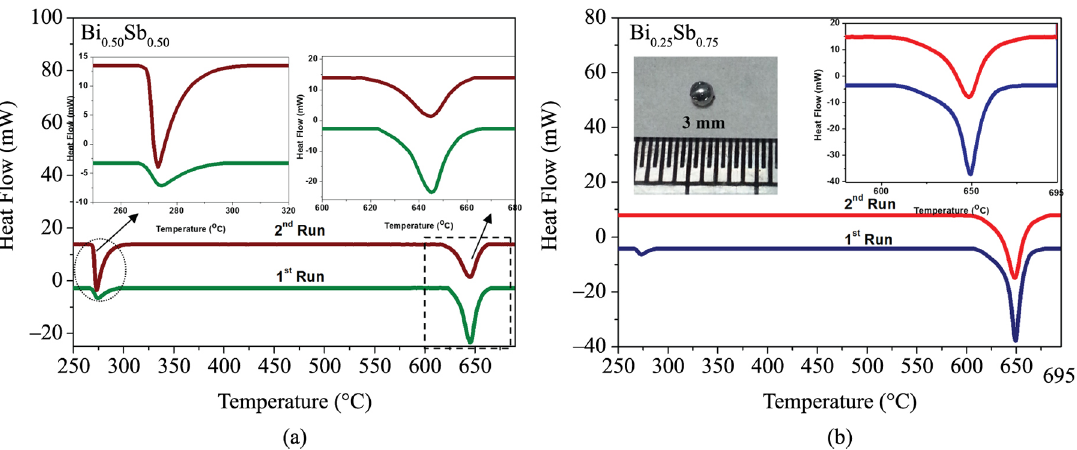
Figure 4. Comparison of 1 st and 2 nd heating cycle of (a) Bi precursor/NaBH as 1:0.5. The right inset shows the magnified views of the melting event for clarity. The left inset shows digital photograph 4 of the sample after 1 st heating